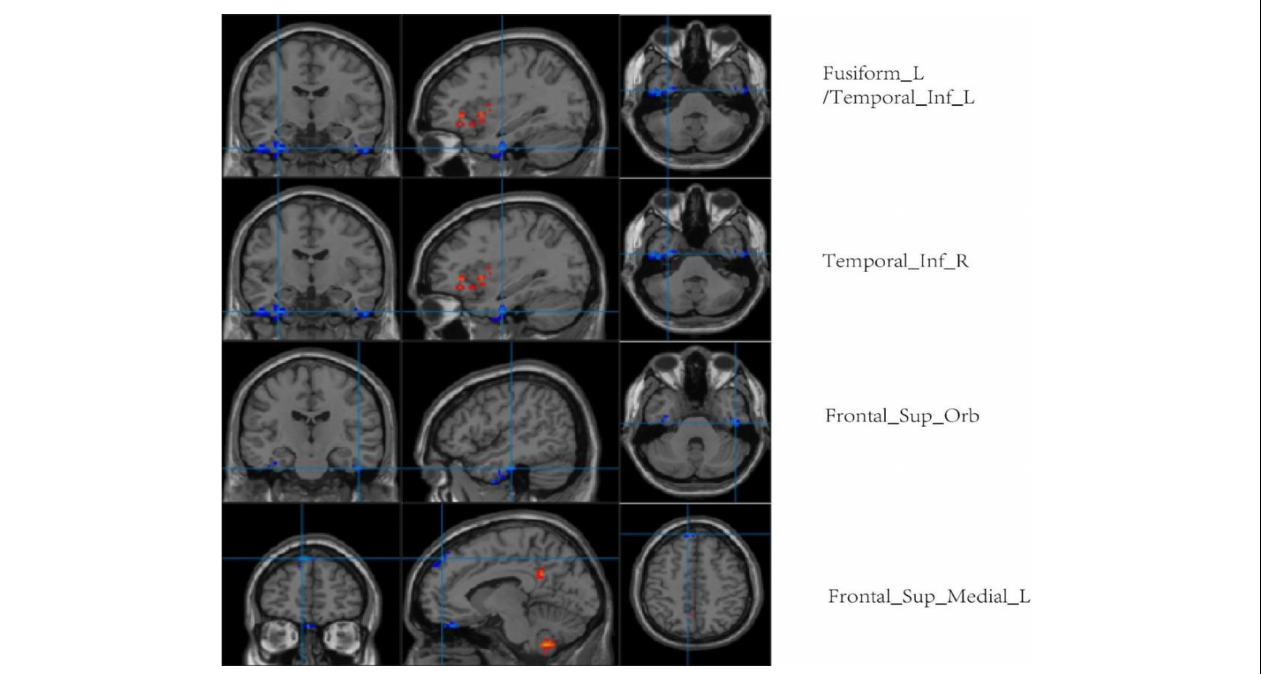
FIGURE 8 | Regional comparison of ALFF values after chronic hypoxia exposure ( p < 0.001, cluster size > 50). Red represents brain regions with reduced ALFF after chronic hypoxia exposure (HA < LA). Blue represents brain regions of individuals exposed to chronic hypoxia with elevated ALFF (HA > LA).